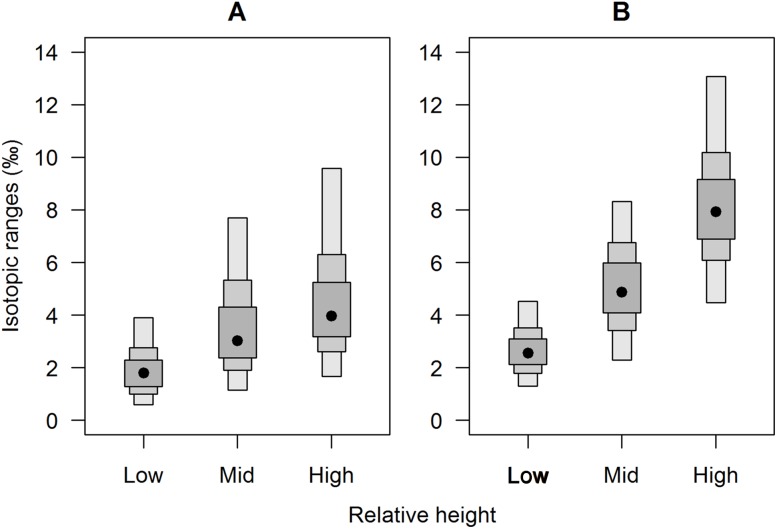
Separate (A) carbon and (B) nitrogen isotopic variation of E. peruviana individuals from different shore heights.Range estimates calculated by a Bayesian implementation of Layman et al. (2007) in the R package SIBER (Jackson et al., 2011). A black dot shows the mode, while boxes represent the 95, 75 and 50% credible intervals.